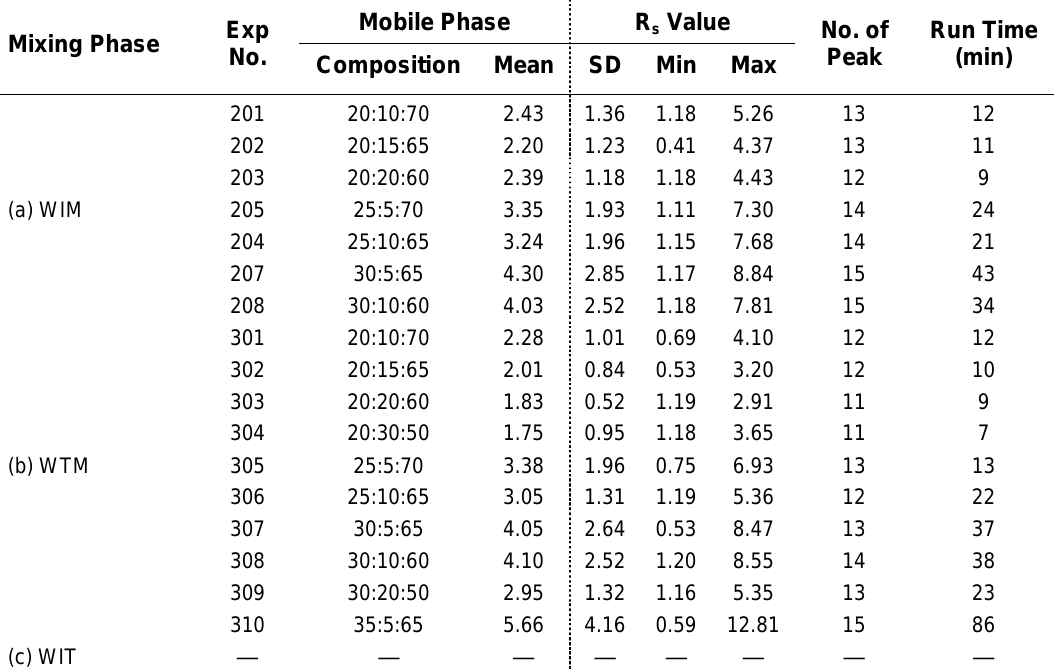
Summary of All Experiments in Terms of Resolution (R Experiment Modes and Compound Types A. Comparison between Different Experiment